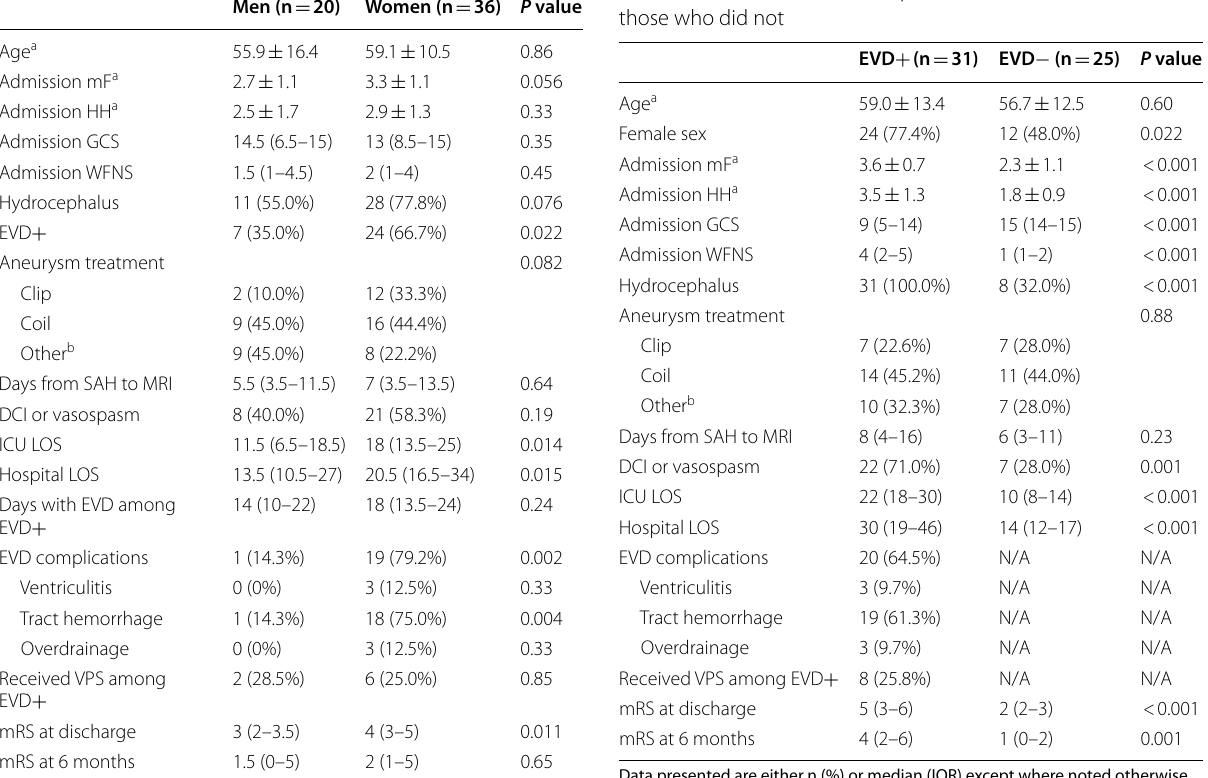
Table 2 Differences between patients who received EVDs